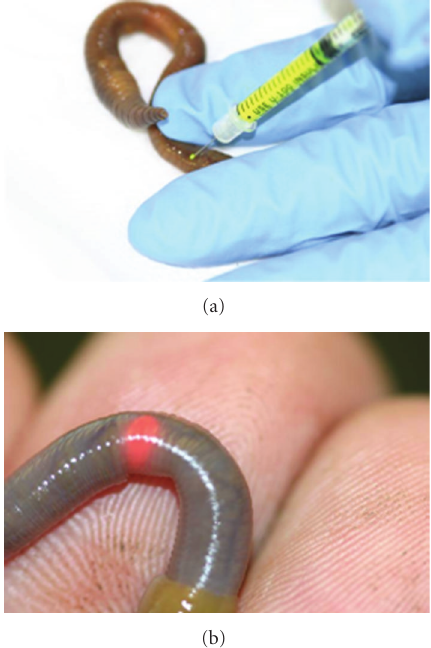
Figure 8: (a) Injection of yellow Visual Implant Elastomer (VIE) into Lumbricus terrestris ; (b) Octolasion cyaneum with a red VIE tag